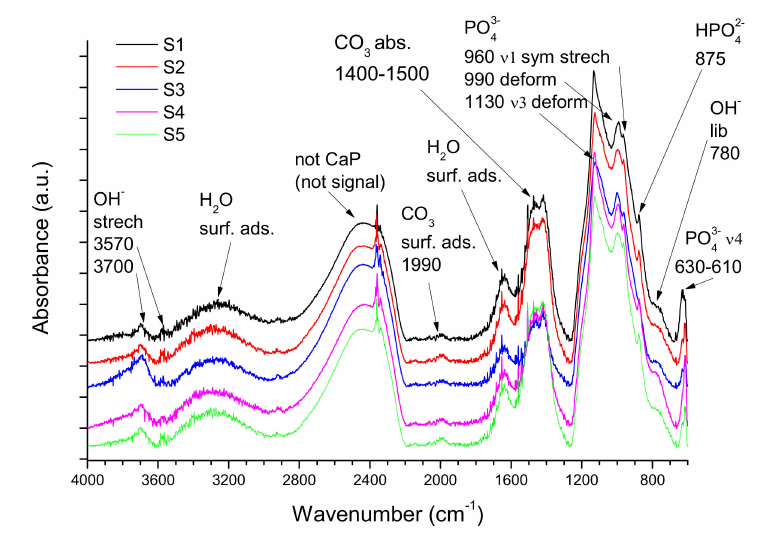
Figure 4. FTIR measurements on CPC layers prepared by the pulse current with di ff erent parameters.